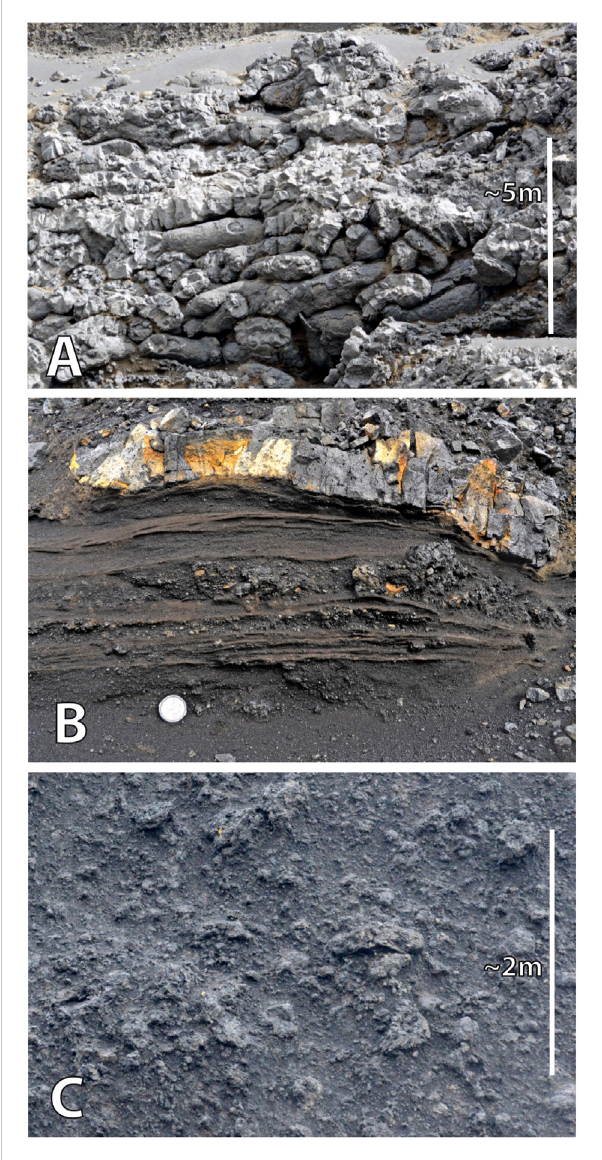
FIGURE 4 Field images of critical lithofacies. (A) Shallowly plunging pillow lava tubes from Lp2 in the central wall of Vatnsskarð quarry. View is approximately 30 m across horizontally. (B) Thinly laminated beds of tuff and lapilli tuff in the northeastern wall of Vatnsskarð quarry (lens cap for scale). (C) View of tuff-breccia unit between Lp2 and Lp3 in the central wall of Vatnsskarð quarry. Largest bombs/pillow fragments are approximately 50 cm in diameter (outcrop was unreachable).